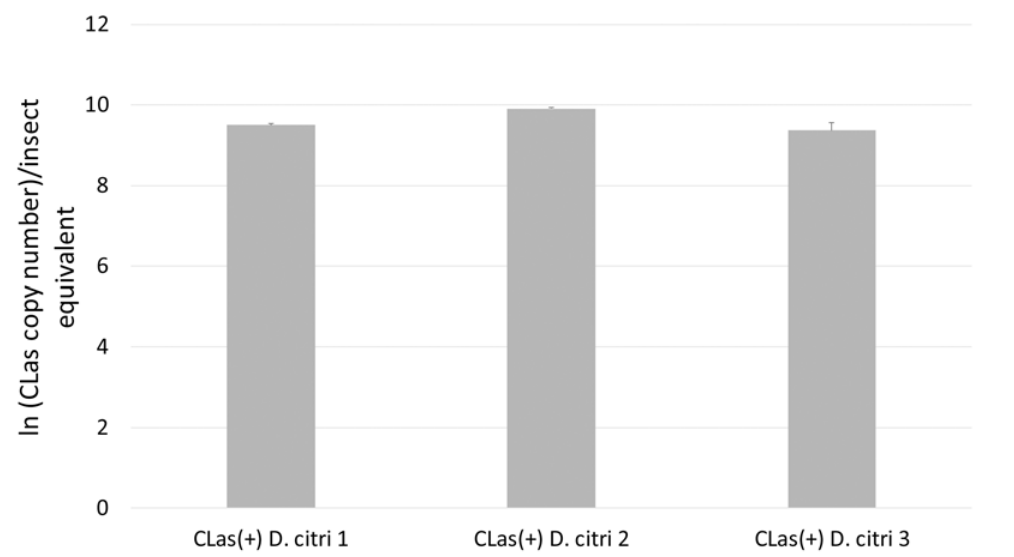
Fig 1. CLas qPCR analysis of D . citri samples. CLas copy number in D . citri samples (three replicates) was estimated using qPCR targeting the 16s rRNA gene. Ct values from biological samples were compared to a dilution series of a synthetic plasmid corresponding to the CLas 16s rRNA target gene. Natural logarithm of estimated CLas copy number per insect equivalent is shown on the Y-axis. All reactions were performed in triplicate (mean plus standard deviation). No signal was observed within 40 cycles for CLas(-) samples.